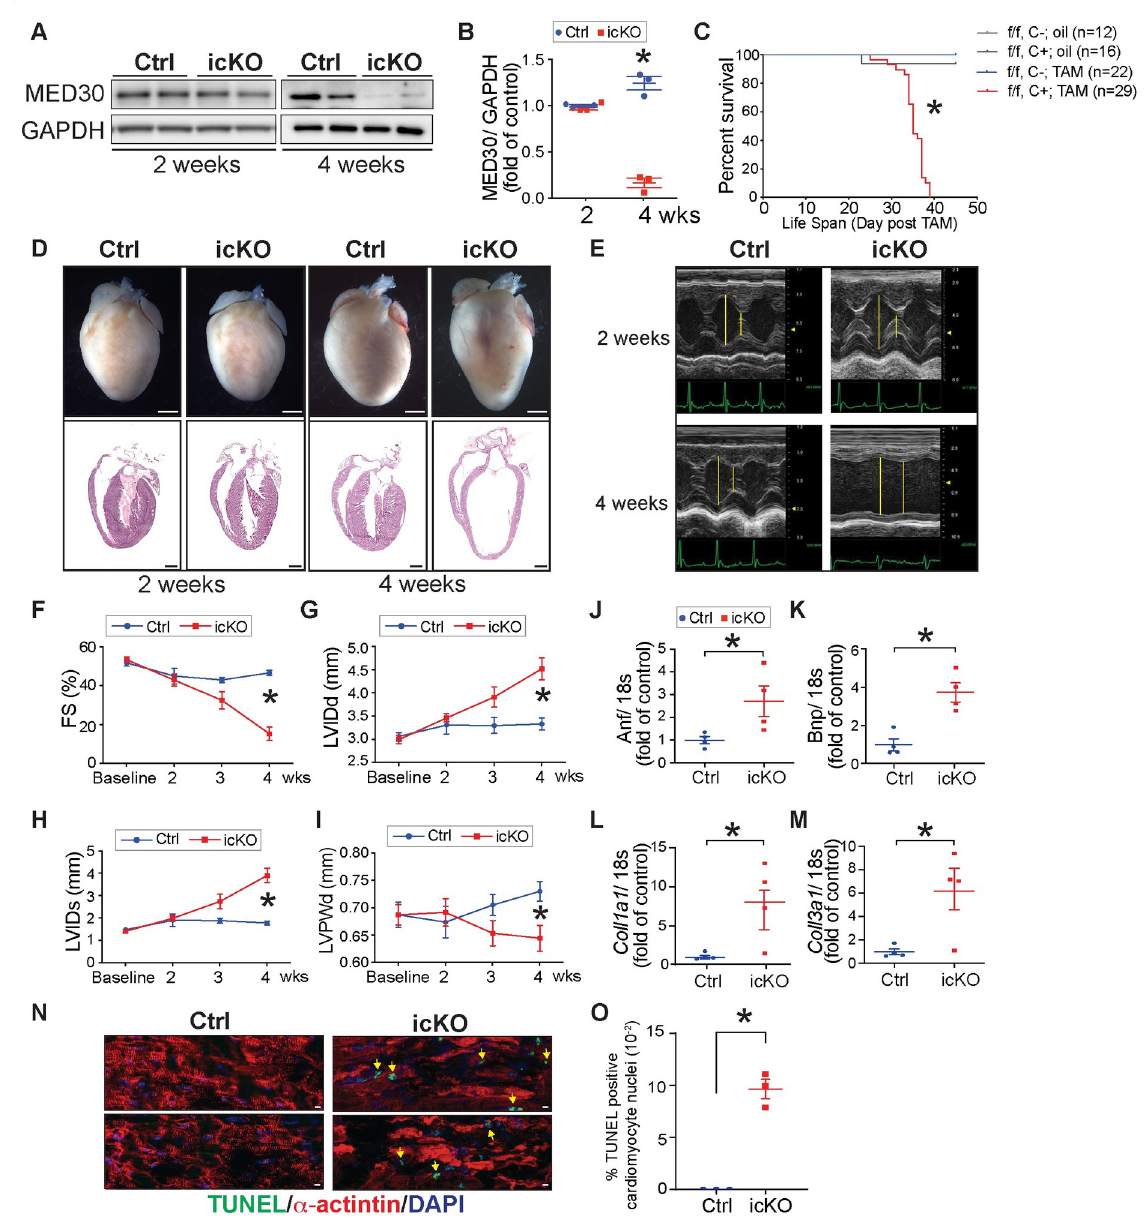
Fig 4. MED30 deletion in adult cardiomyocyte leads to rapidly developed dilated cardiomyopathy (DCM) and lethality. (A-B) Representative immunoblots (A) and quantification analysis (B) of MED30 in the heart isolated from inducible Med30 cardiomyocyte specific knockout (icKO) and control (Ctrl) mice at 2 weeks and 4 weeks post-tamoxifen injection. GAPDH served as a loading control. n = 3. (C) Kaplan-Meier survival curves of Med30 icKO and control and mice after oil (n = 12–16) or tamoxifen injection (n = 22–29). (D) Representative hearts (top) and H&E stained sections (bottom) of Med30 icKO and Ctrl mice at 2 weeks and 4 weeks post-tamoxifen injection. (E) Representative M-mode echocardiography of Med30 icKO and Ctrl mice at 2 weeks and 4 weeks post-tamoxifen injection. (F-I) Echocardiographic measurements for Med30 icKO and Ctrl mice at baseline, 2, 3 and 4 weeks (wks) post-tamoxifen injection by (F) fractional shortening (FS), and left ventricular (LV) internal dimensions at (G) end-diastole (LVIDd) and (H) end-systole (LVIDs), as well as LV posterior wall thickness at the end-diastolic (LVPWd). n = 14 mice per group. (J-M) qRT-PCR analysis of cardiac fetal gene markers atrial natriuretic factor (Anf) (J) and B-type natriuretic peptide (Bnp) (K), and profibrotic genes, collagen α 1 types I ( Col1a1 ) (L) and III ( Col3a1 ) (M), in control and icKO mouse hearts at 4 weeks post-tamoxifen injection. Data were normalized to corresponding 18s levels, and icKO is expressed as the fold-change versus control. n = 3. (N-O) Representative immunostaining images (N) and quantification analysis (O) of TUNEL staining (green) in heart sections from Med30 icKO and Ctrl mice at 4 weeks post-tamoxifen injection, using an antibody against α - actinin as cardiomyocyte marker (red). DNA is stained with DAPI (blue). Scale bar: 10 μ m. n = 3. Data are represented as the mean ± SEM. � P < 0.05, by 2-tailed Student’s t test, or by the Kaplan-Meier survival analysis.